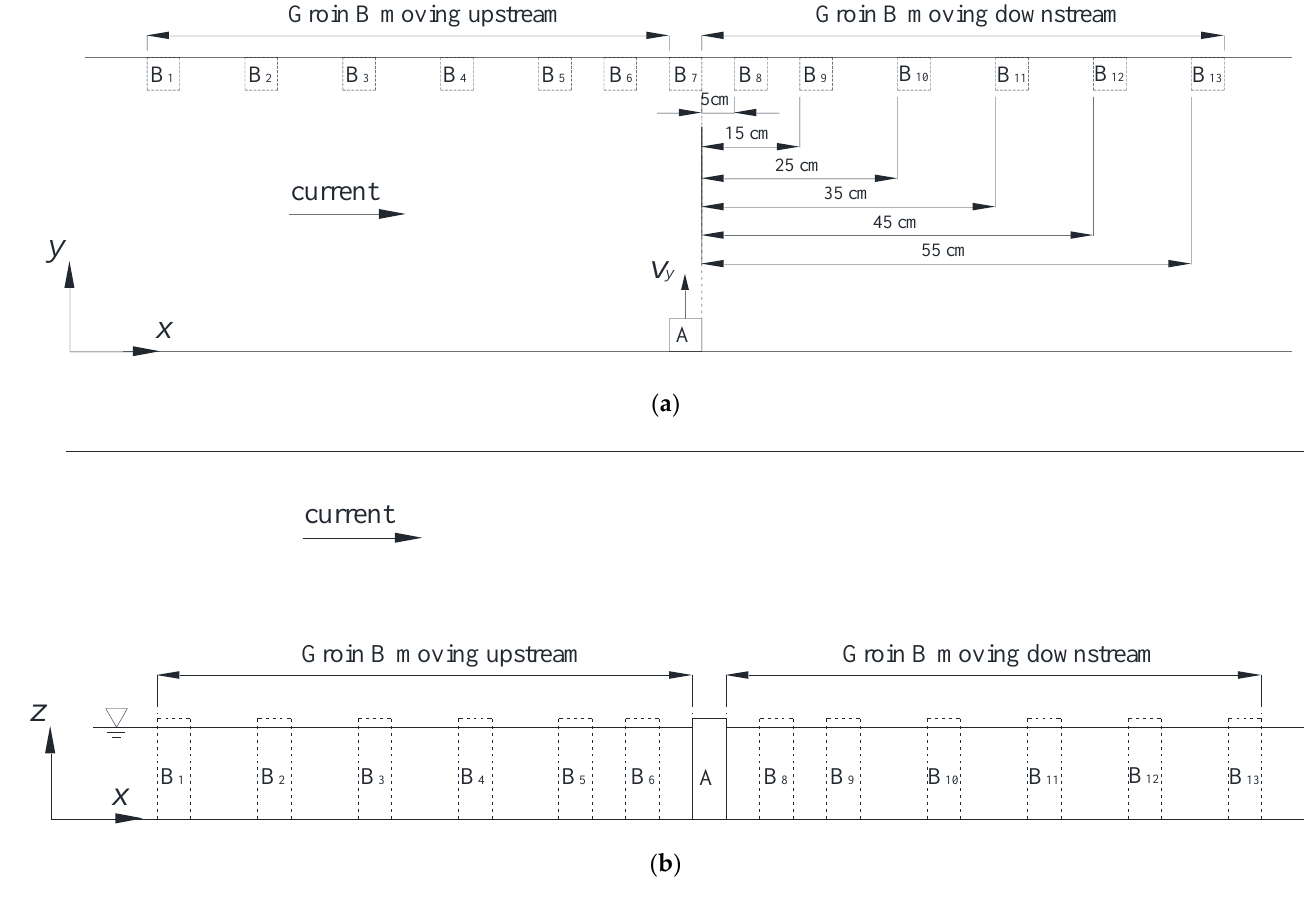
Figure 3. Different groin configuration scenarios. ( a ) Top view; ( b ) side view.